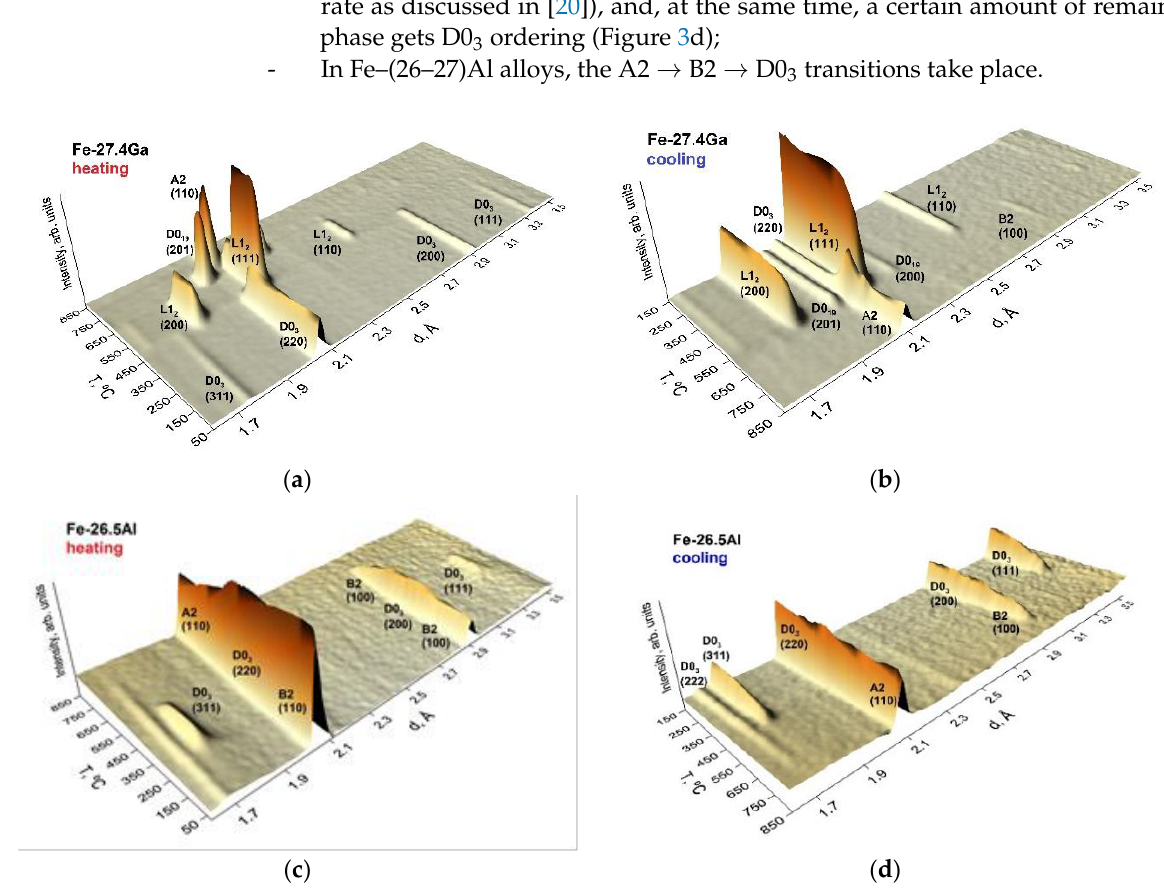
Figure 3. The 3D visualization of in situ neutron diffraction pattern evolution for Fe–27.4Ga ( a , b ) and Fe–26.5Al ( c , d ) water quenched samples at continuous heating ( a , c ) and cooling from 850 °C ( b , d ) [24].